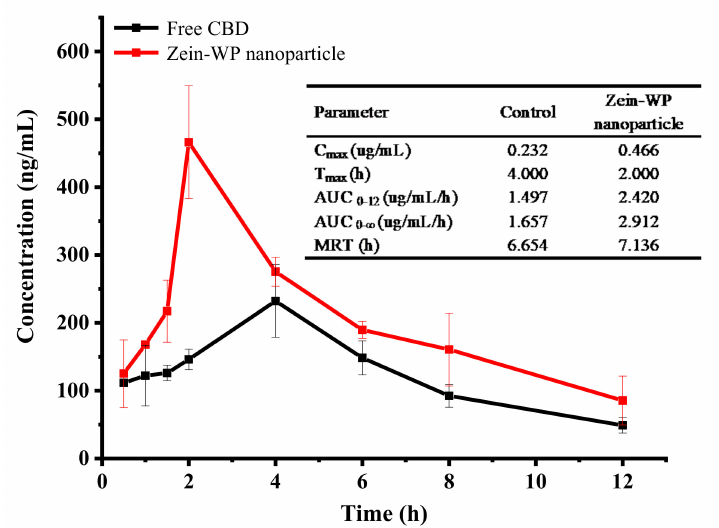
Figure 8. Means of plasma concentration–time profiles and in vivo pharmacokinetic parameters of pure CBD and CBD-loaded zein–WP